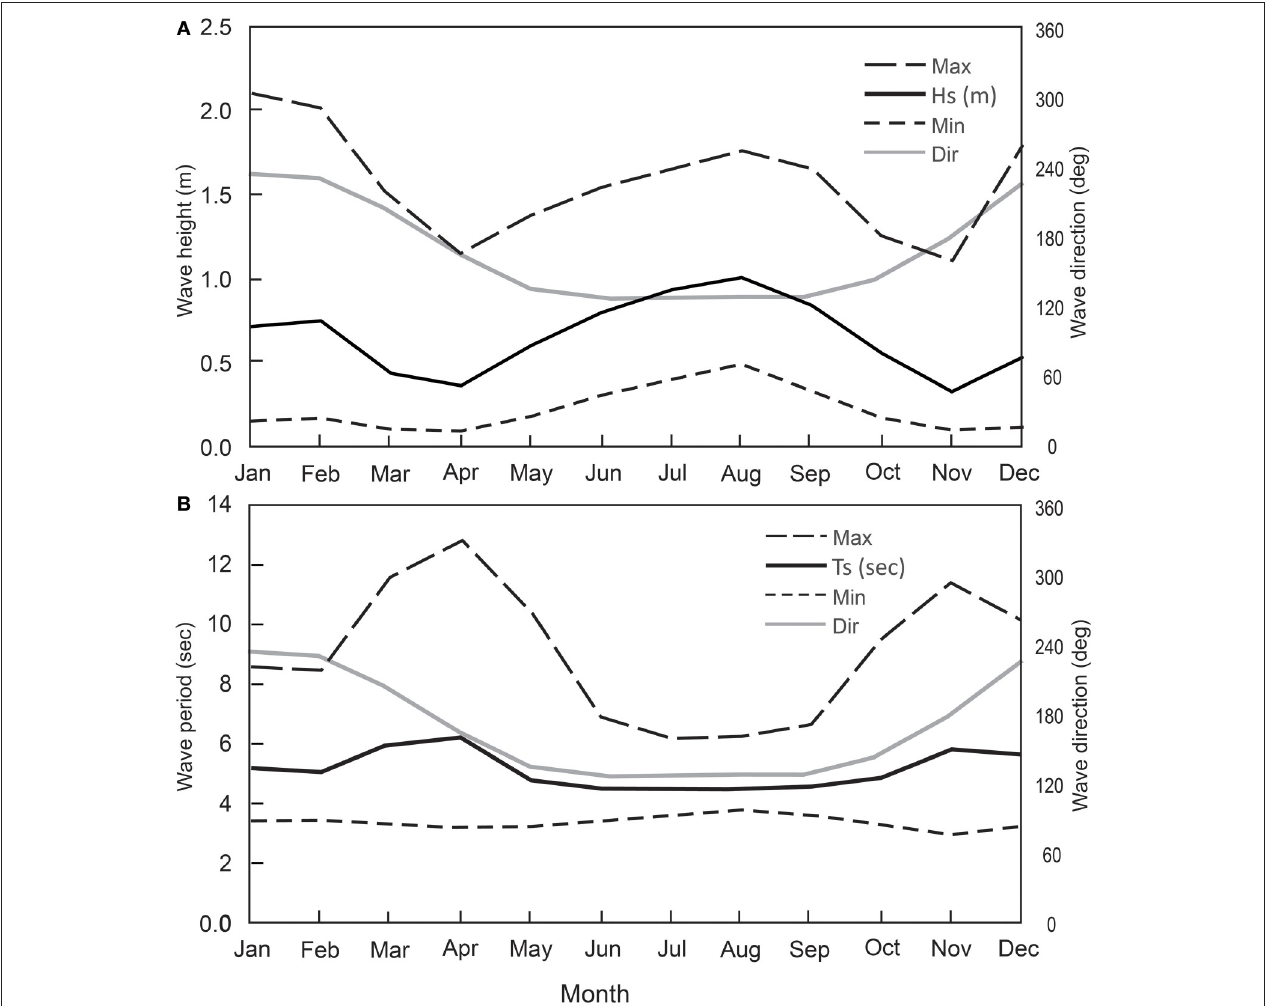
FIGURE 4 | Monthly average of hourly wind and wave data between 1980 and 2010 west of Spermonde. (A) Summary wave height statistics; (B) Wave period statistics. Wave direction shown as gray line in both panels. Source: WWIII records spanning 30 years